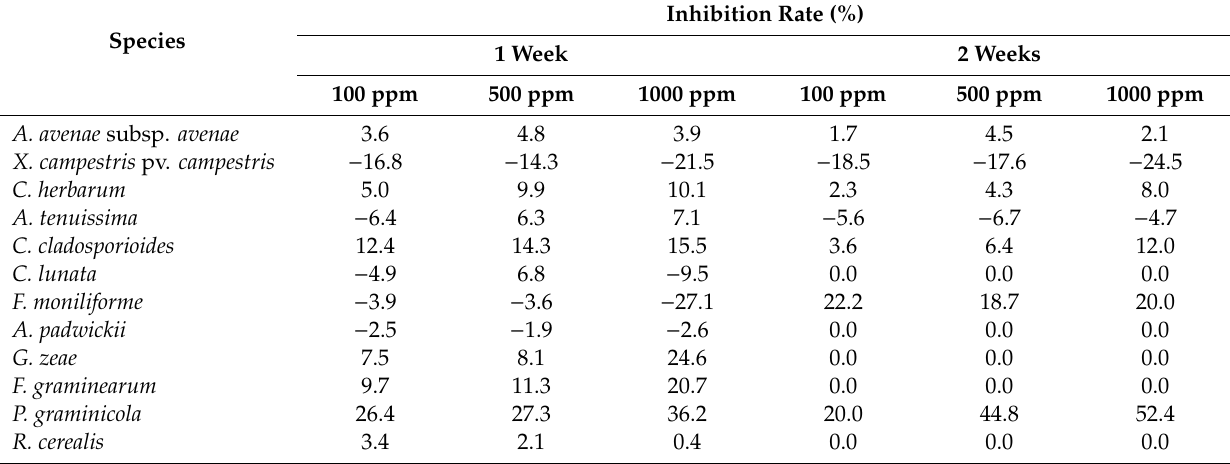
Table 4. Inhibition rate (%) of cochlioquinone 9 against various pathogen species.